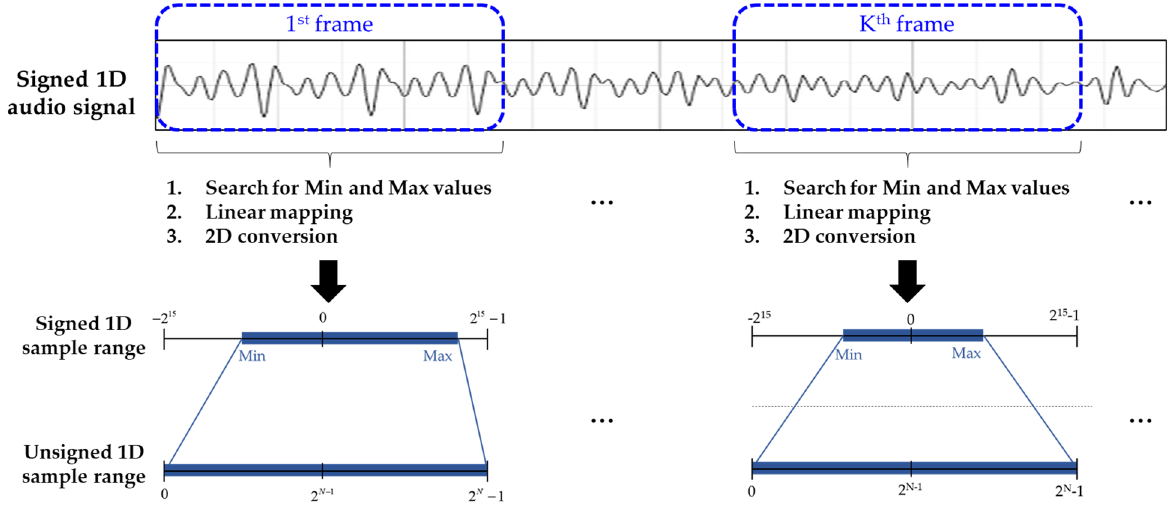
Figure 5. Graphical representation of adaptive linear mapping.